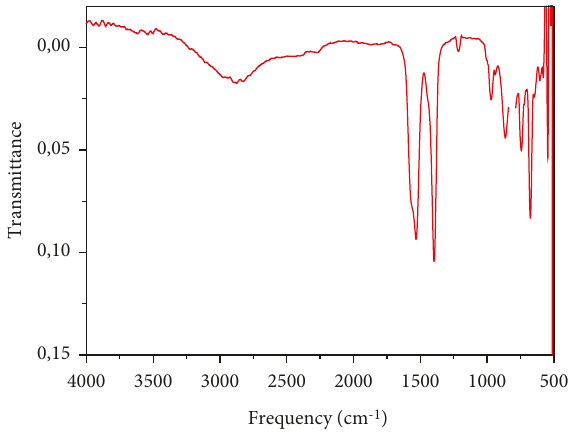
Figure 1: Infrared spectrum of copper (II)